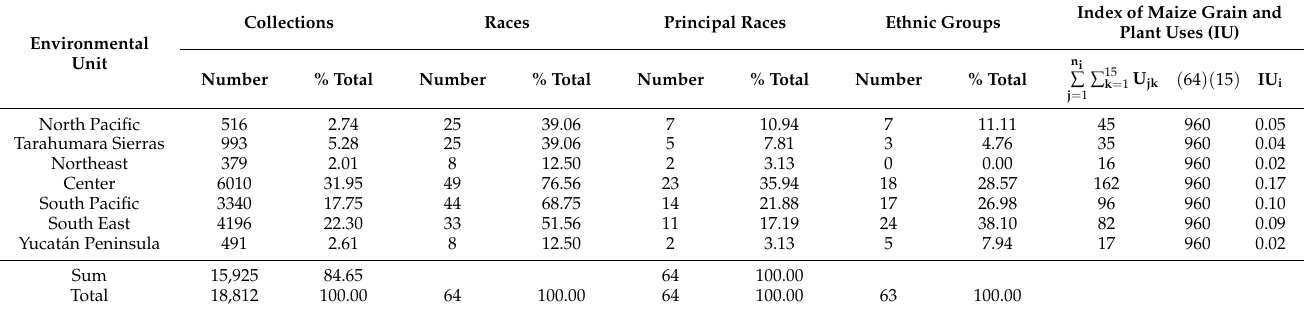
Table 1. Number of collections, number of races, number of principal races, ethnic groups, and index of maize grain and plant uses inside each environmental unit.